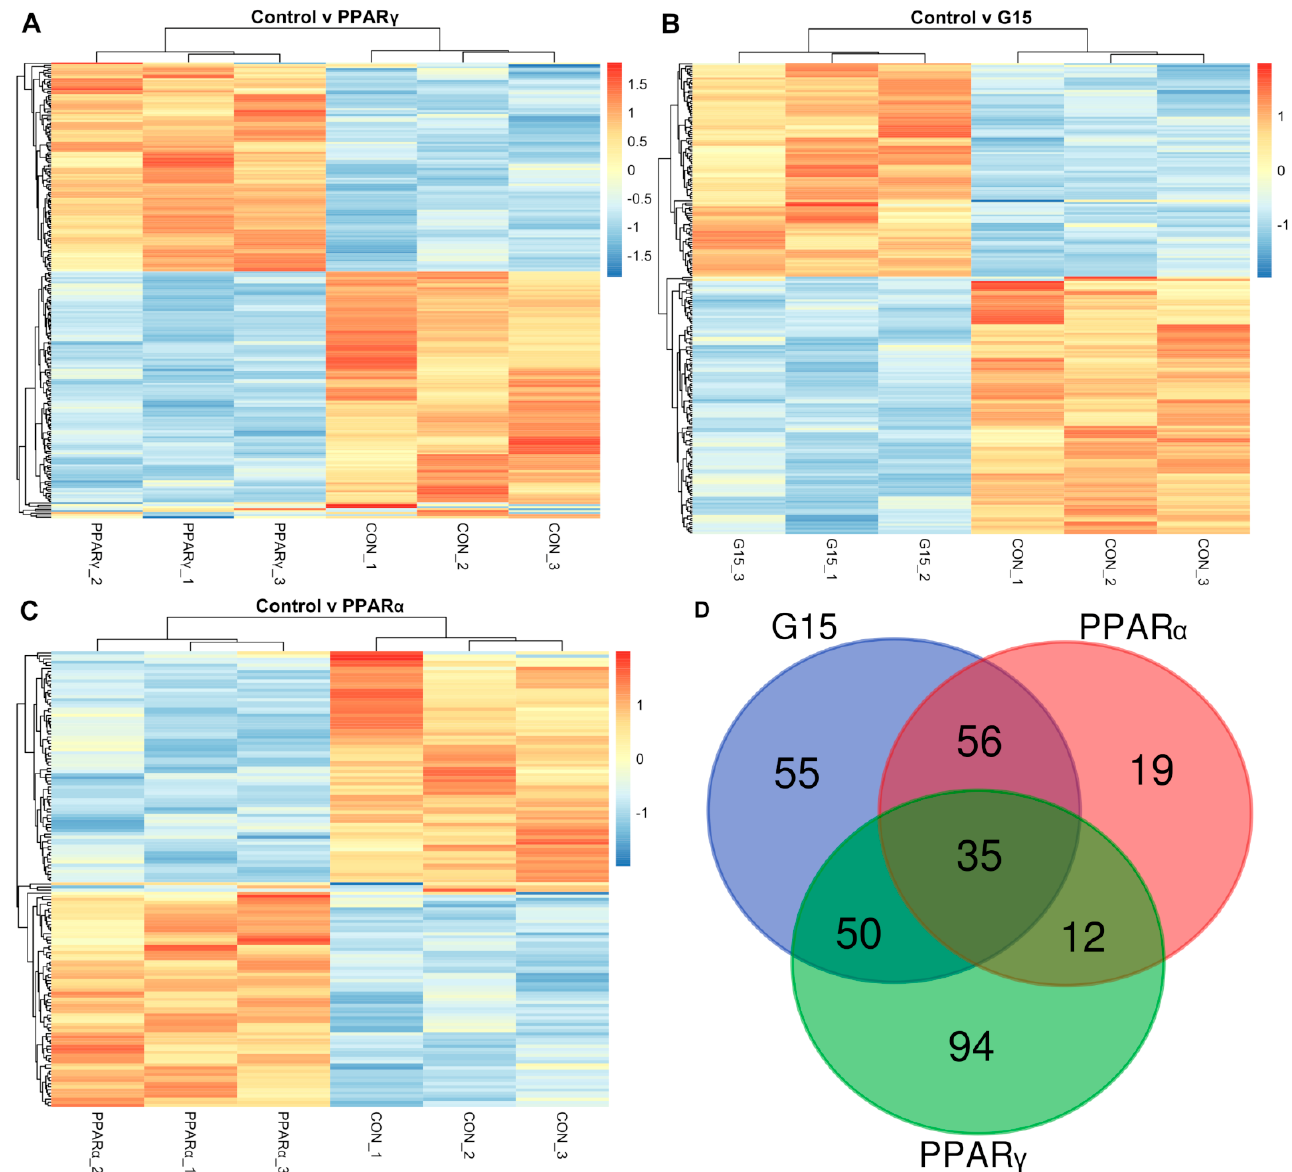
Figure 3. Expression profiles based on genes differentially expressed between control group (CON) and and ( A ) group treated with PPAR γ antagonist (PPAR γ ), ( B ) G15group treated with G15 antagonist (G15) and ( C ) group treated with PPAR α antagonist (PPAR α ). See Results (paragraph 3.5) for differentially expressed genes. ( D )Venn diagram demonstrating the number of differentially expressed genes in experimental groups (PPAR α —group treated with PPAR α antagonist, PPAR γ —group treated with PPAR γ antagonist, G15—group treated with G15 antagonist).